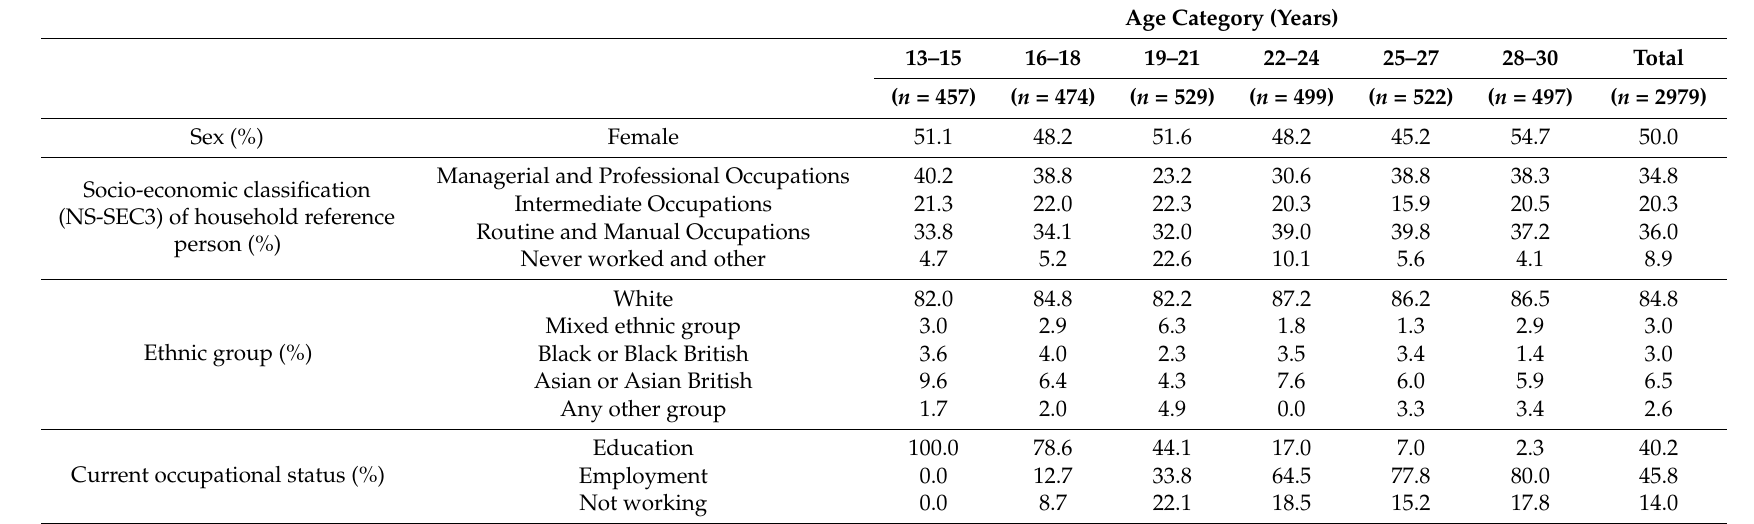
Table 1. Socio-demographic data on the weighted sample by age category from the NDNS Rolling Programme, years